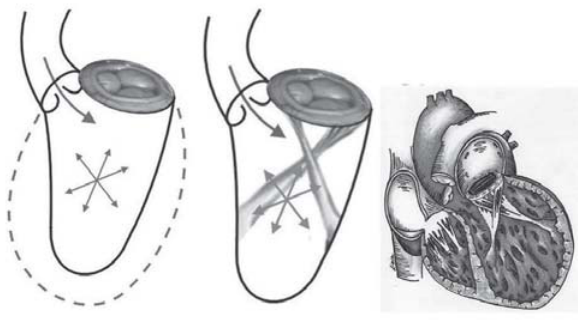
Fig.6 - Prótese mitral com preservação dos elementos do sistema subvalvar: papilopexia cruzada. (Gomes et al., Rev Bras Cir Cardiovasc.